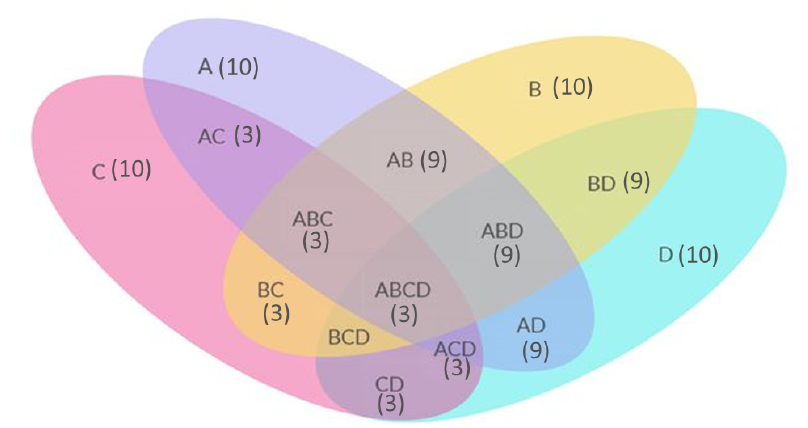
Figure 6. Venn Diagram showing the common features among the feature sets.